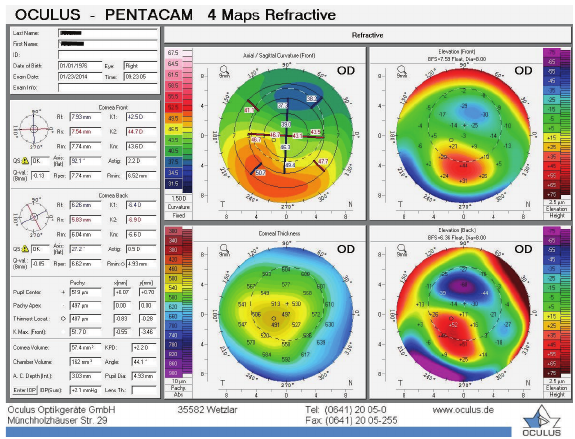
Figure 3: Patient 1, right eye at the last